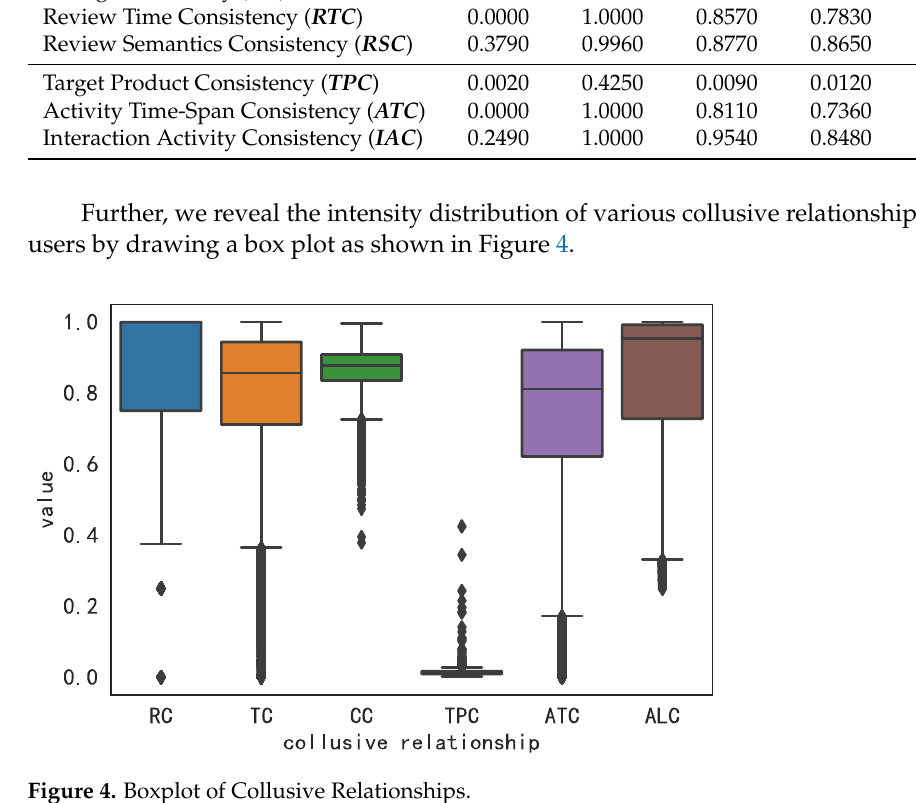
Figure 4. Boxplot of Collusive Relationships